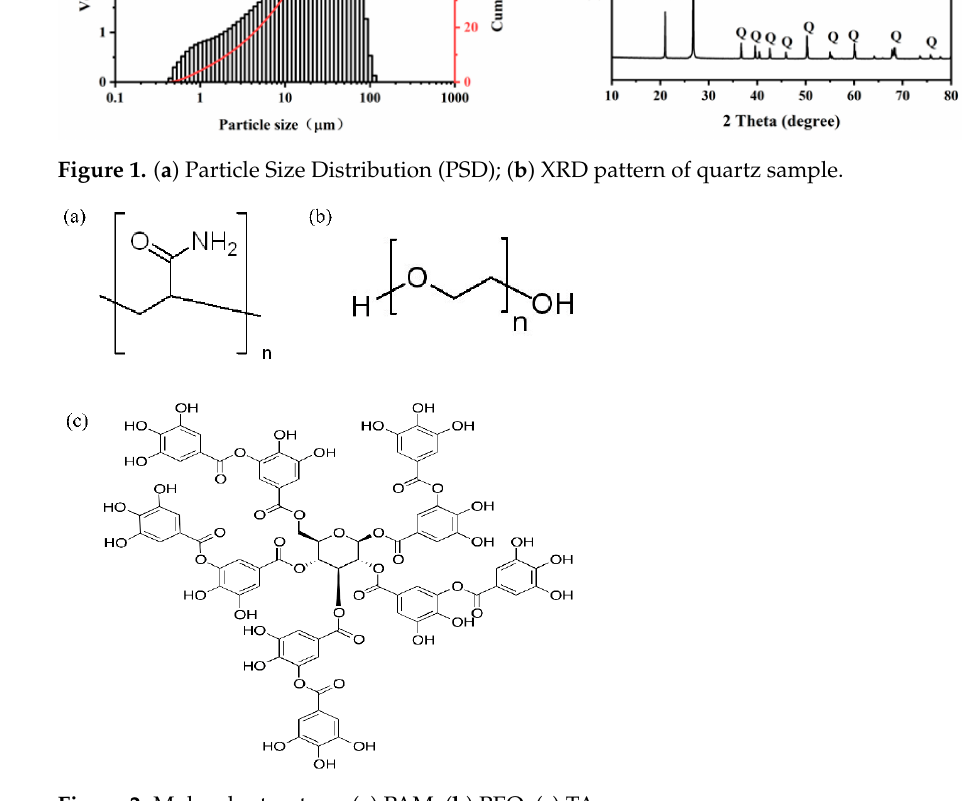
Table 1. Flocculants/Cofactors used in this study.